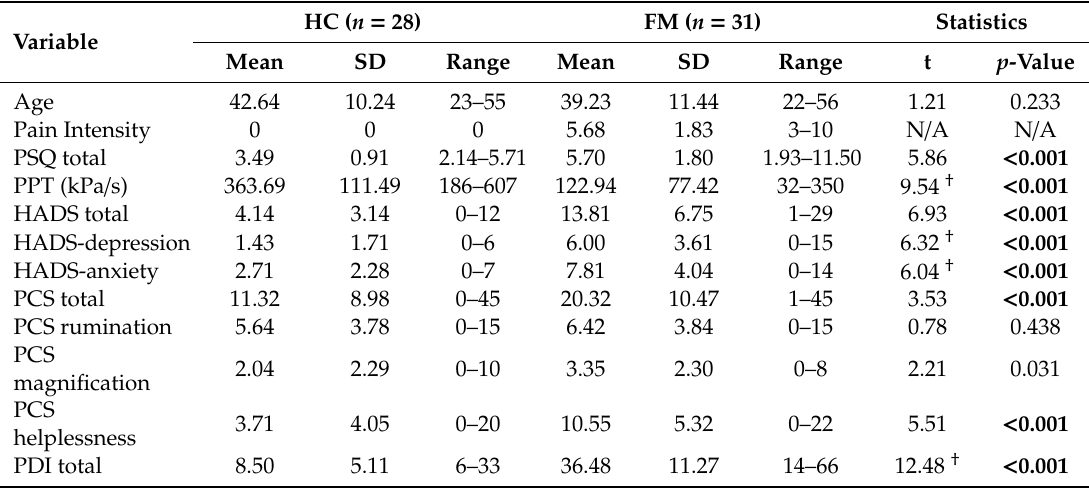
Table 2. Group statistics for questionnaires and PPT including t -test and corresponding p -values on between-group (FM vs. HC) di ff erences. HC ( n = Variable